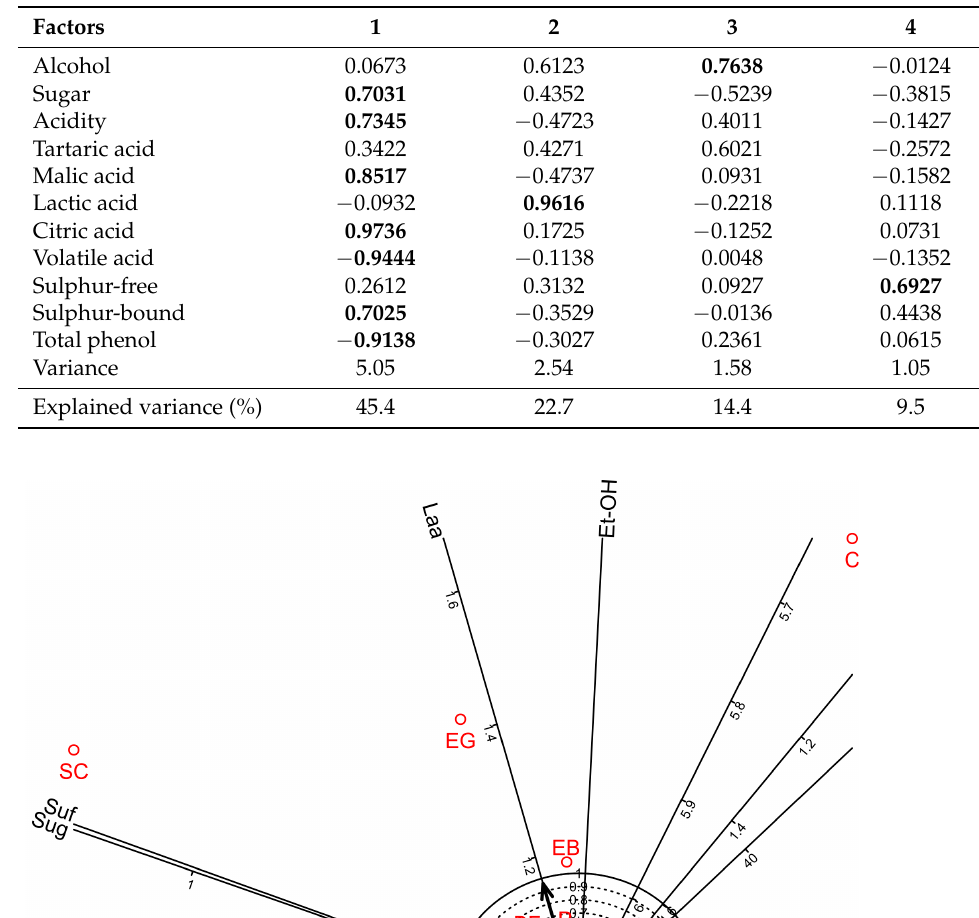
Table 9. Factor loadings calculated from Principal Axis Factor Analysis (Varimax rotation) for ten oenological measurements of white wine samples in twenty-one bentonite product treatments (Debrecen-Pallag, Hungary). Factor loadings above 0.69 were significant at p = 0.05. Bold figures represent the significant ( p < 0.05) factor loadings.